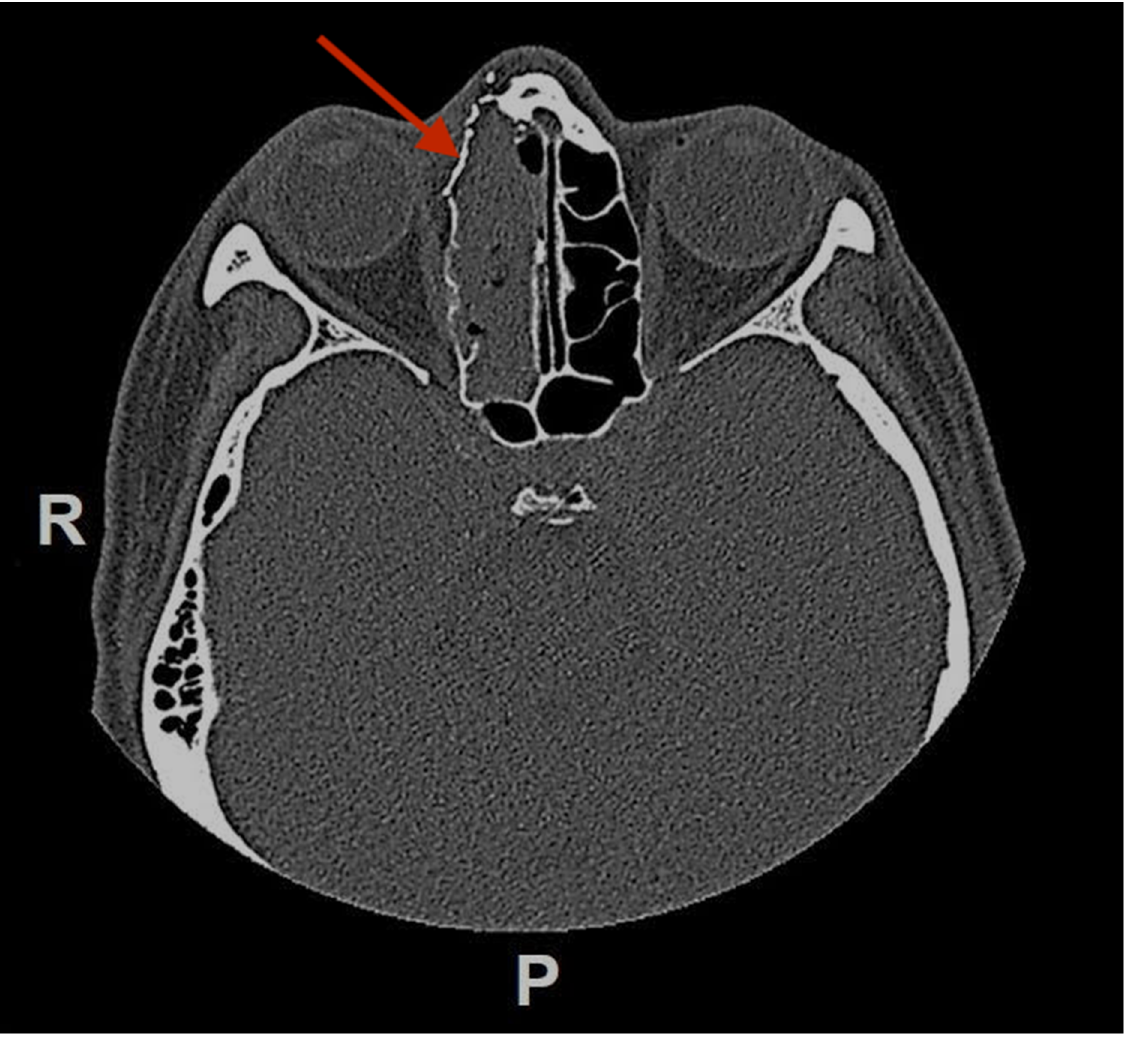
Figure 6. Postoperative (3 weeks) CT-scan in axial view showing the reconstruction of the medial right orbit wall with a titanium mesh. (red arrow pointing at the titanium mesh). R = right, P =